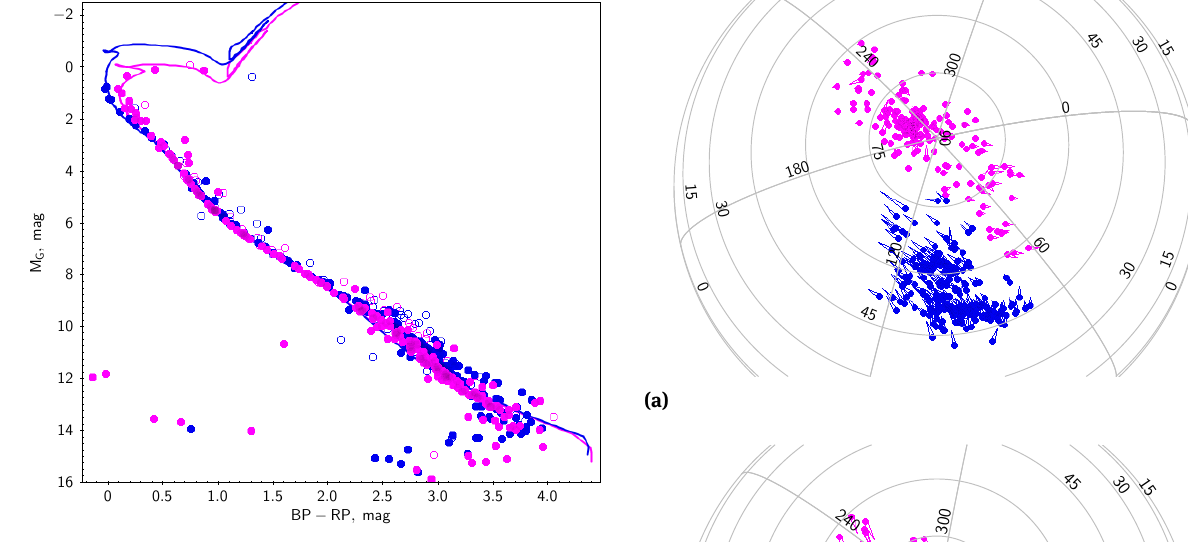
Figure 6. Stars referred to Coma Ber cluster (magenta dots) and to Group X (blue dots) along with fitted isochrones. Empty dots are for the stars filtered out because of quality of astrometric solution (not used for isochrone fitting), filled dots for astrometrically pure sources